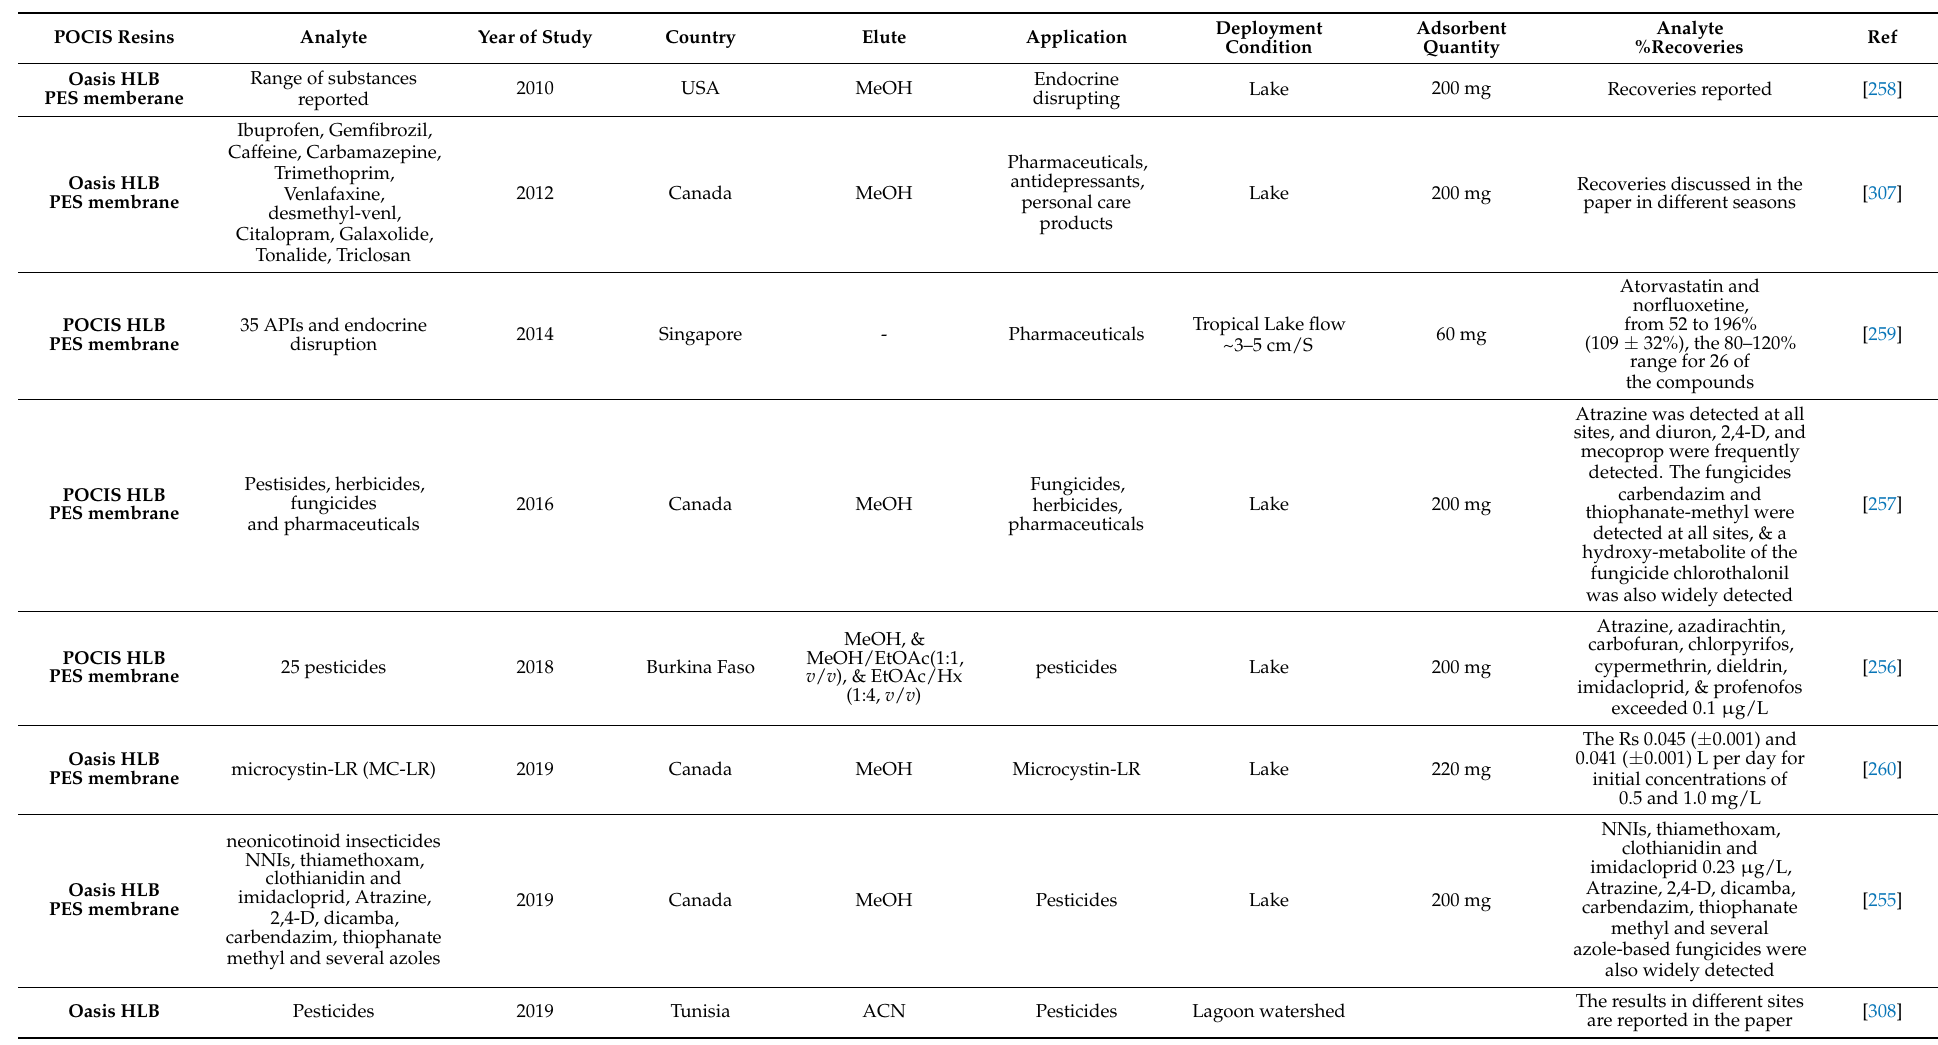
Table 9. Application of POCIS on Lake